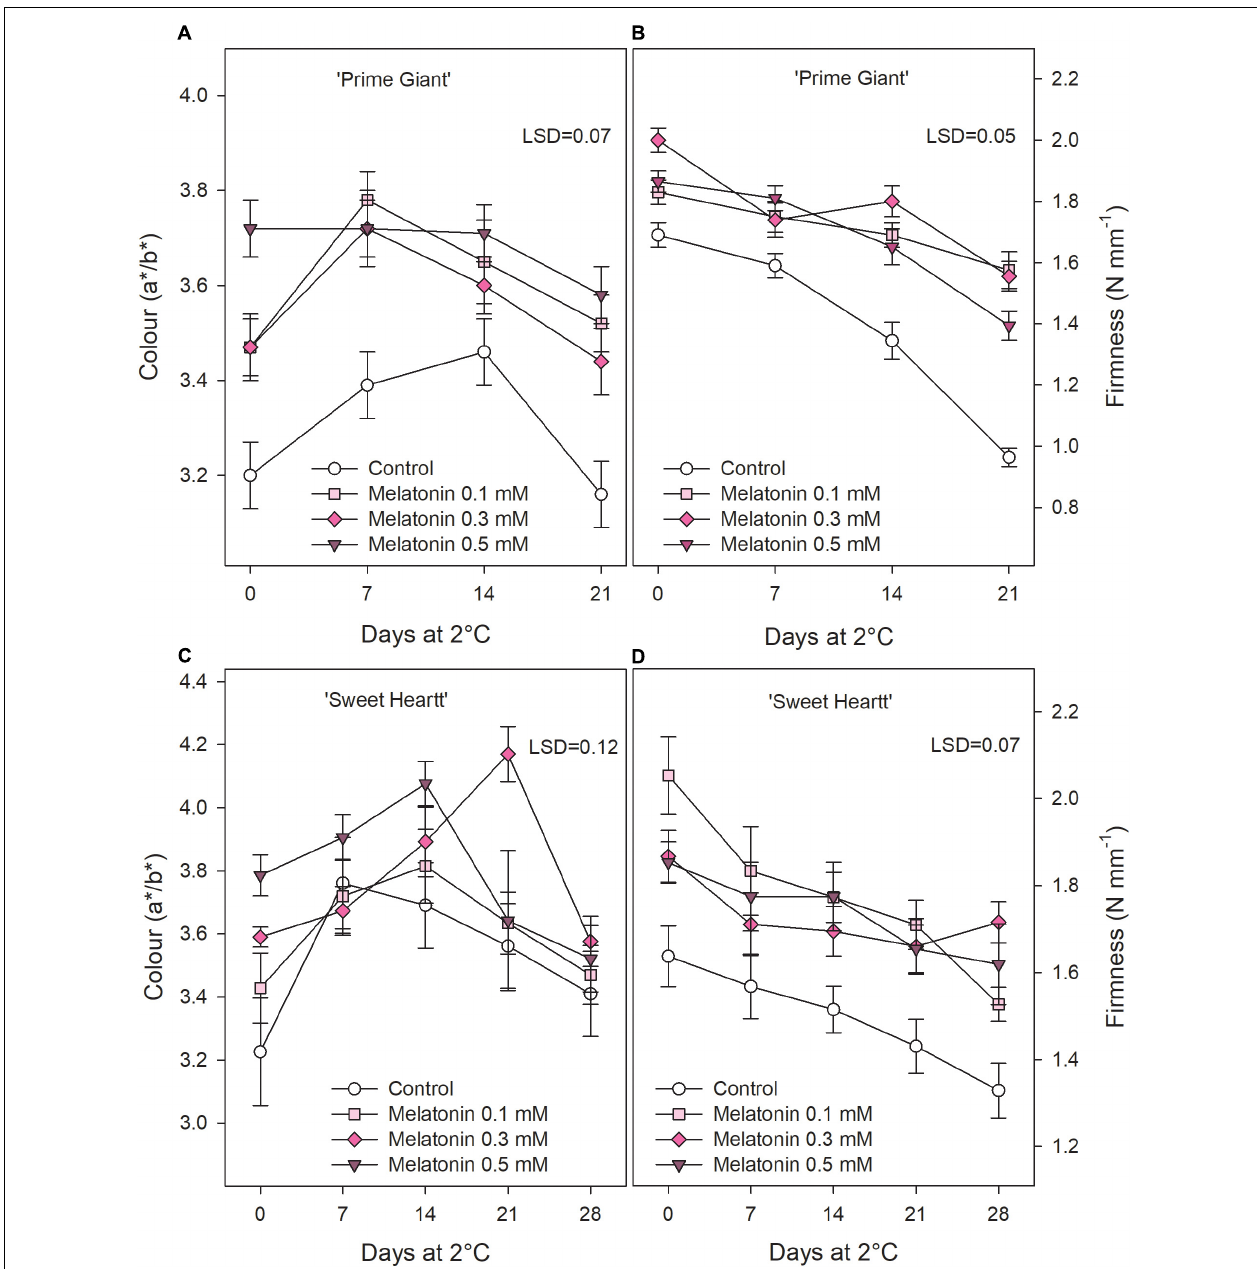
FIGURE 2 | Fruit colour (A) and firmness (B) for ‘Prime Giant’ and ‘Sweet Heart’ (C,D) cultivars during storage at 2 ◦ C as affected by melatonin pre-harvest treatments. Data are the mean ± SE of three replicates of 20 fruits. LSD values at ( p < 0.05) are shown in each